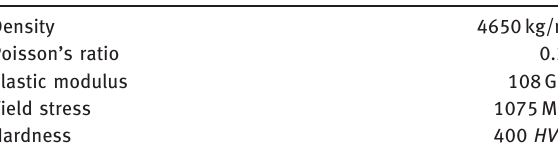
Table 2: Basic material properties of Ti-17 titanium alloy.